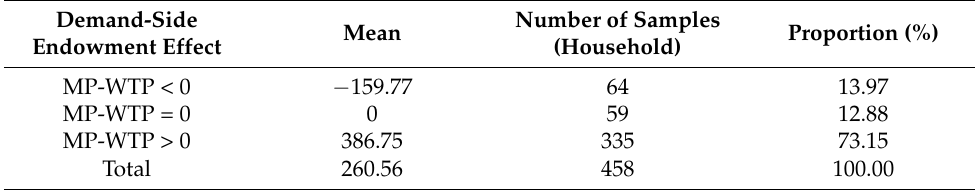
Table 4. Statistical results of the demand-side endowment effect.